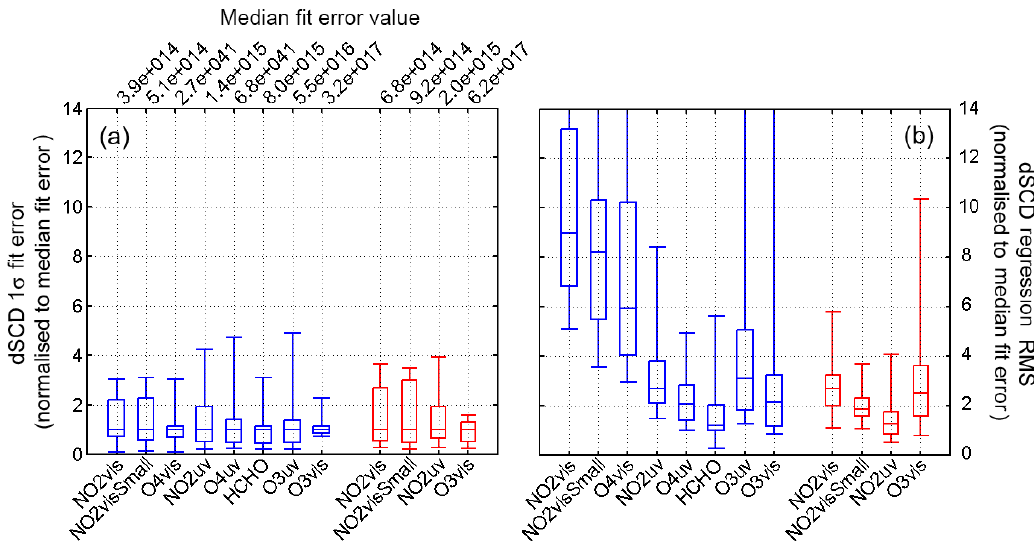
Figure 13. (a) Box-and-whisker plot of the 1 σ fit error of the dSCDs for the 12 data products, for all instruments and for all elevation angles. MAX-DOAS products are represented in blue and zenith-sky twilight in red. (b) Box-and-whisker plot of the rms from dSCD regression analyses, again for the 12 data products under investigation.